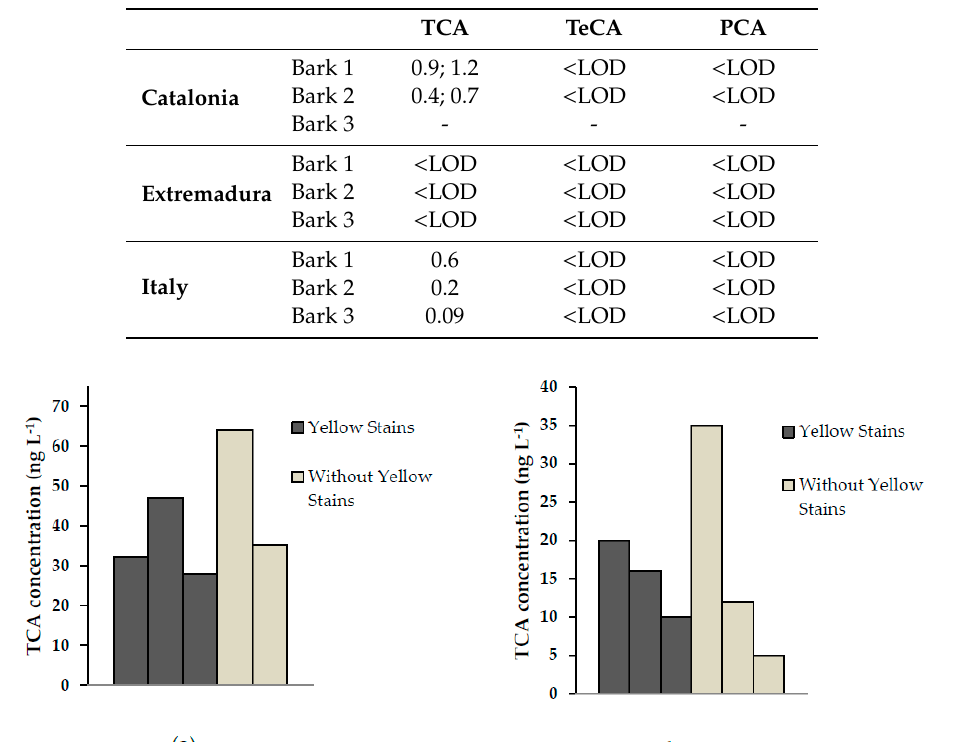
Table 6. Chloroanisoles found in cork samples without yellow stains from Catalonia (two replicates), Extremadura and Italy in ng · g − 1 .